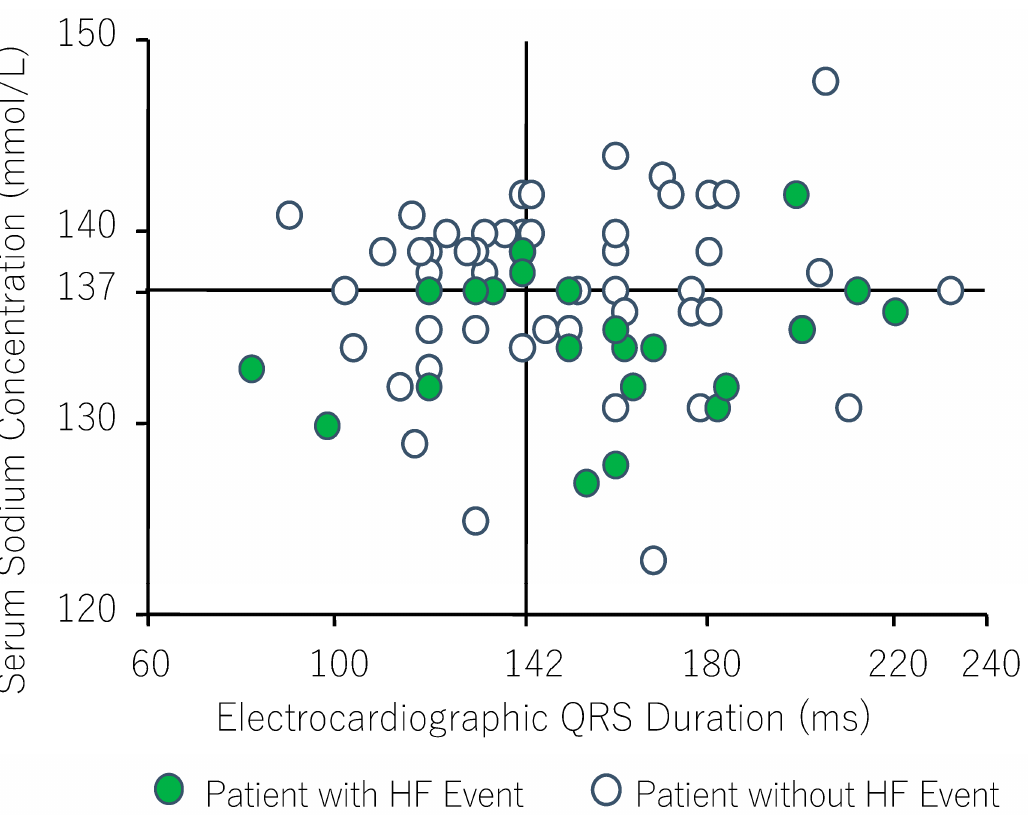
Figure 3. Distribution of serum Na levels and electrocardiographic QRS duration in patients with congestive heart failure. Each solid line shows the median value. Heart failure events occurred more often in hyponatremic patients, especially those with widened QRS duration. Cited from Ref. [26].